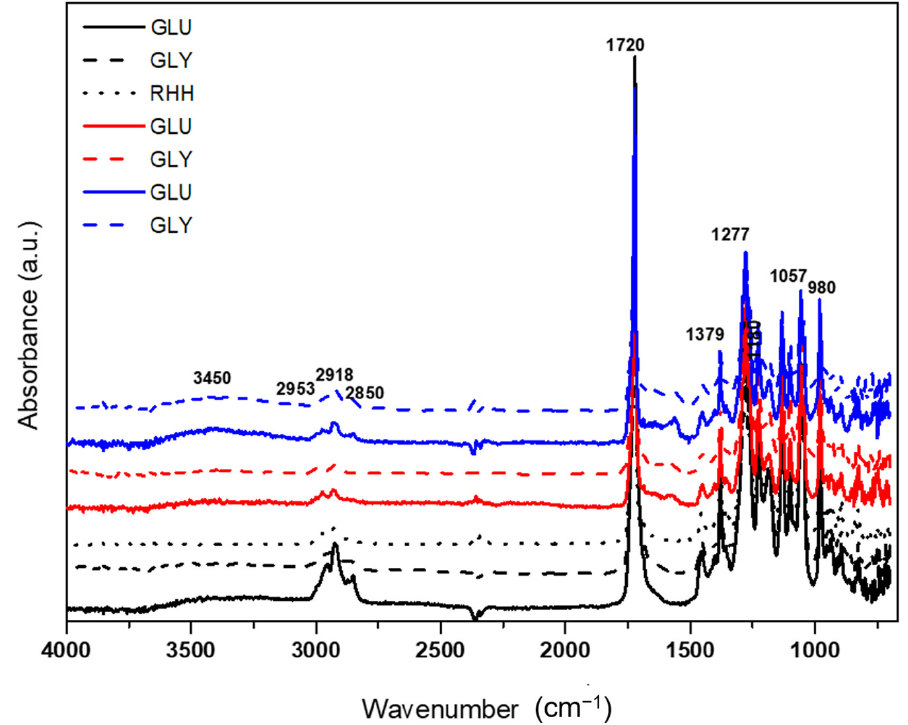
Figure 2. Spectrum of FTIR of PHA produced with glucose (GLU), crude glycerol (GLY), and rice hull hydrolysate (RHH) and extracted with chloroform (black), sodium hypochlorite (red), and with chloroform and sodium hypochlorite (blue).